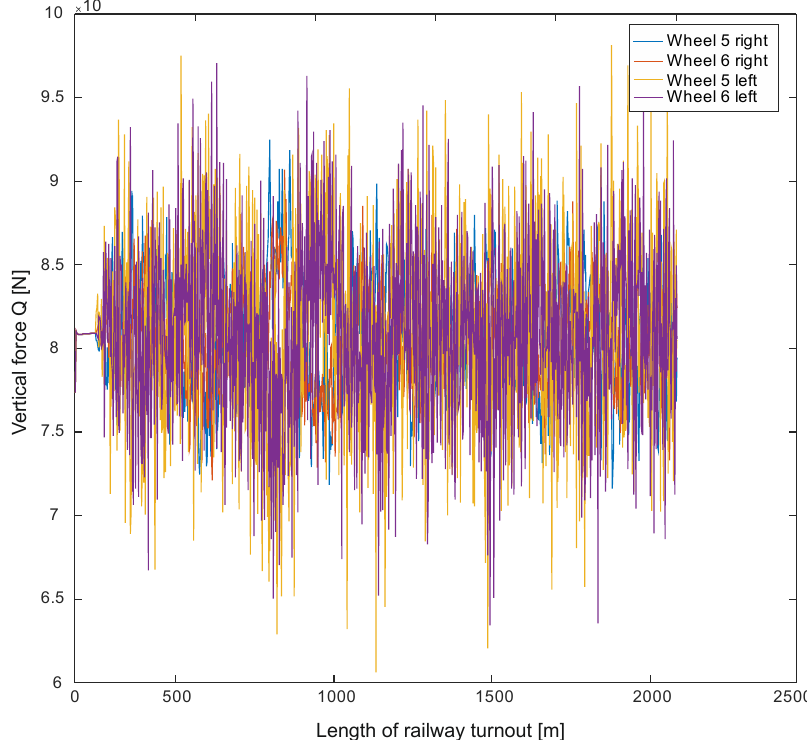
Figure 23 . Vertical force at 300 km/h on a straight track without a turnout.